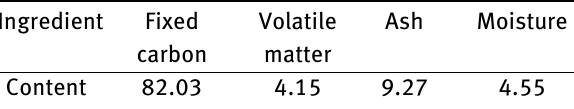
Table 2: Industrial analysis results of reducing agent coke %